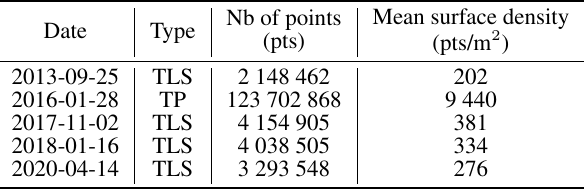
Table 1. Varengeville-sur-Mer PCs